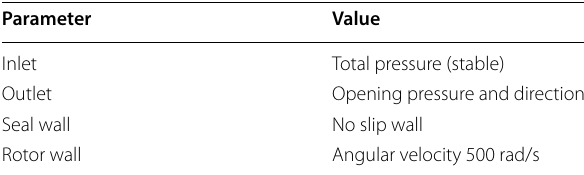
Table 1 Geometrical dimensions and operation conditions